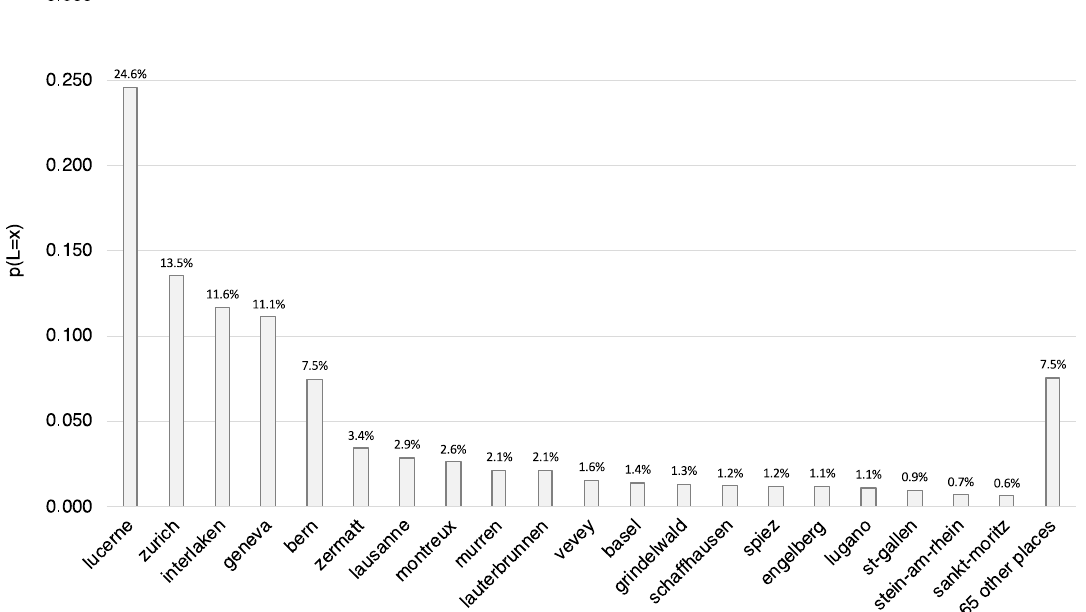
Figure 3. The relative frequency of geotagged Qyer reviews (user comments) of places in Switzerland shows a long-tail distribution ( n = 15,136).